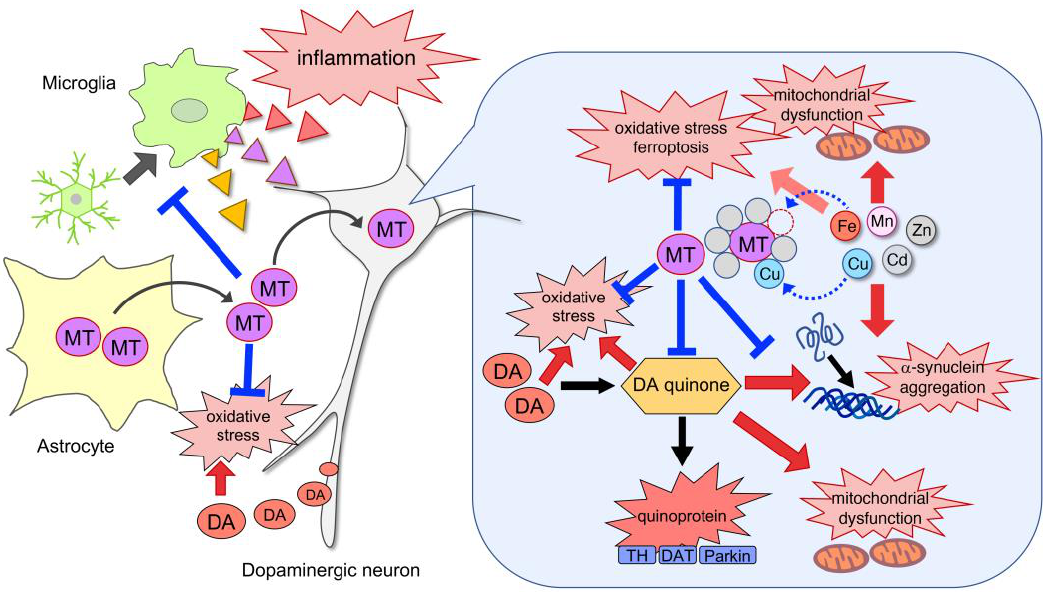
Figure 2. Neuroprotective functions of MTs against dopaminergic neurotoxicity. MT1A/2A are produced in astrocytes and secreted extracellularly. In the extracellular space, MTs ameliorate oxidative stress and microglial inflammatory actions by secretion of inflammatory cytokines (triangles). Extracellular MTs are taken up by dopaminergic neurons and the MTs exert neuroprotective effects.